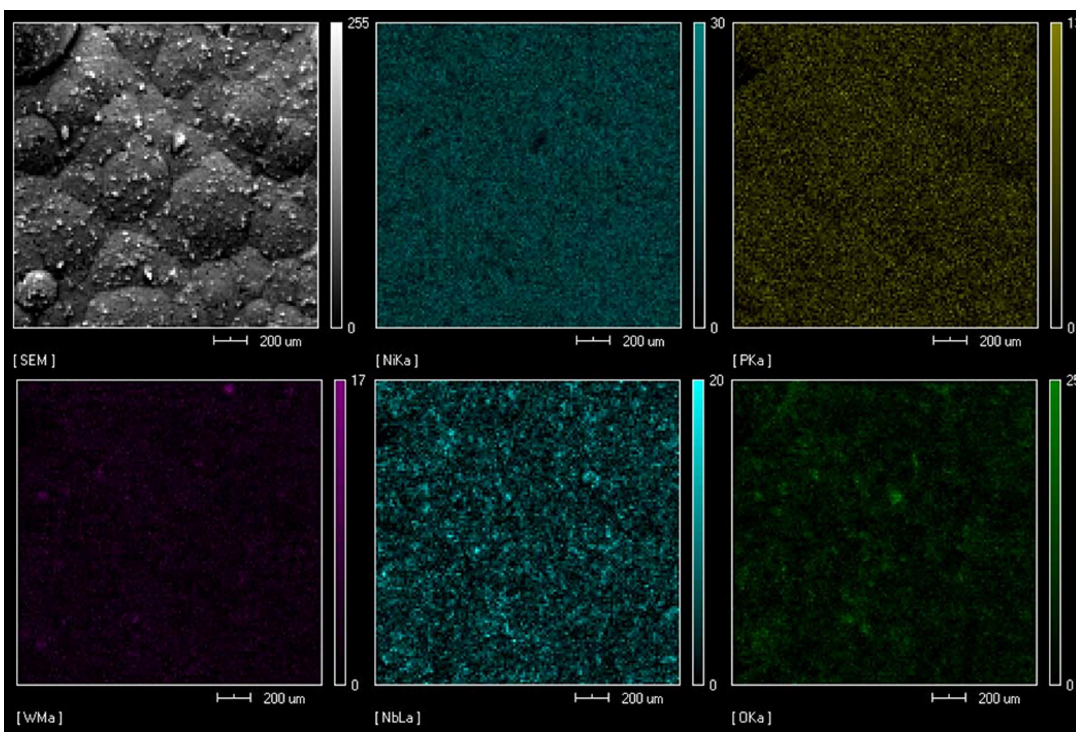
Figure 3. Chemical elements distribution of Ni-P-W/Nb